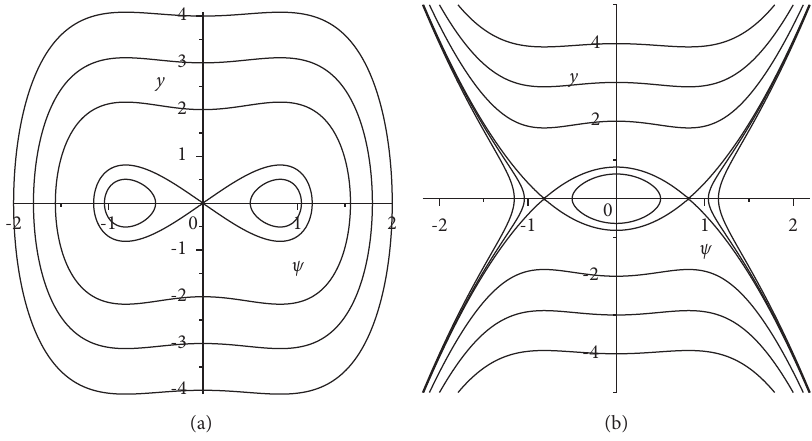
Figure 1: Phase portraits of system (13). (a) A > 0, B > 0. (b) A < 0, B < 0.